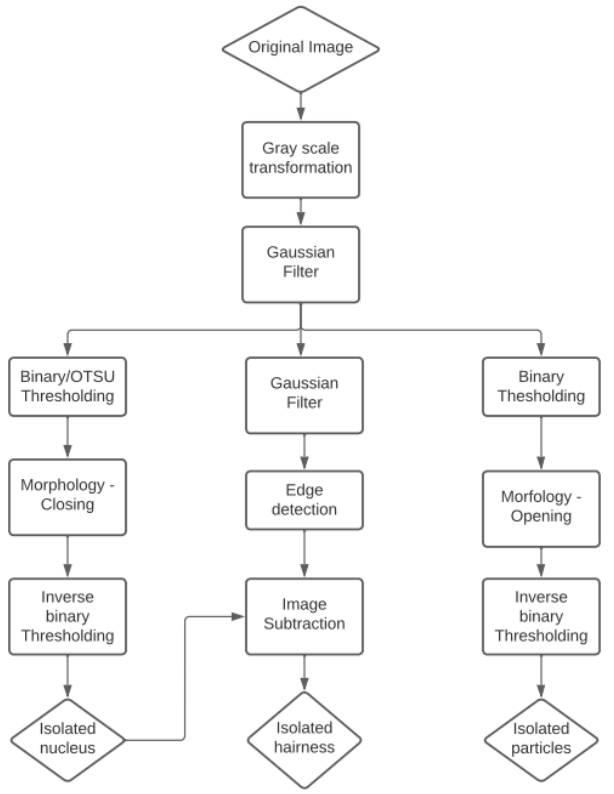
Figure 34. Algorithm analysis methodology flowchart.